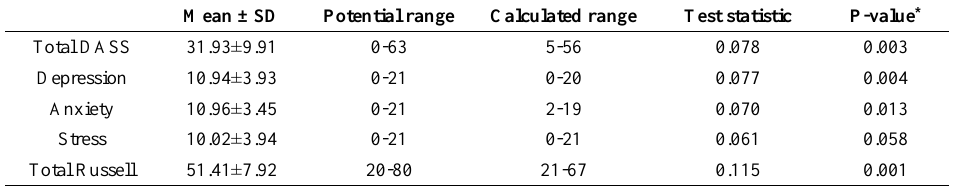
Table 2. Kolmogrov-Smirnov to distribution of depression, anxiety, and stress, and social isolation